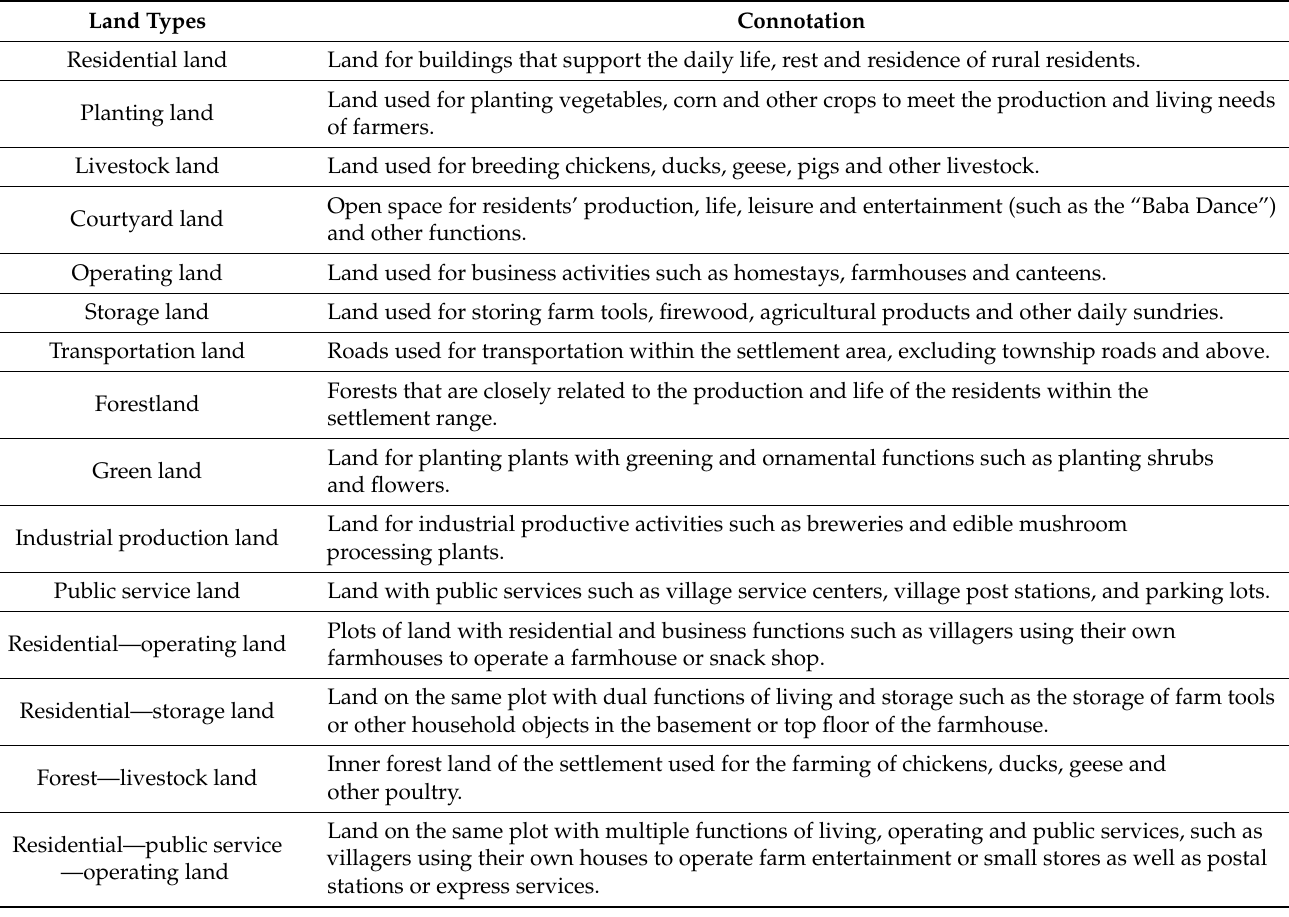
Table 2. Land use classification of rural settlements in the study area in